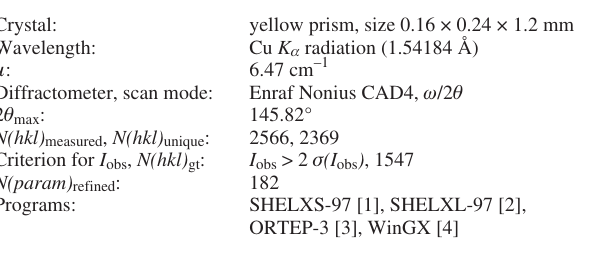
Table 1. Data collection and handling.